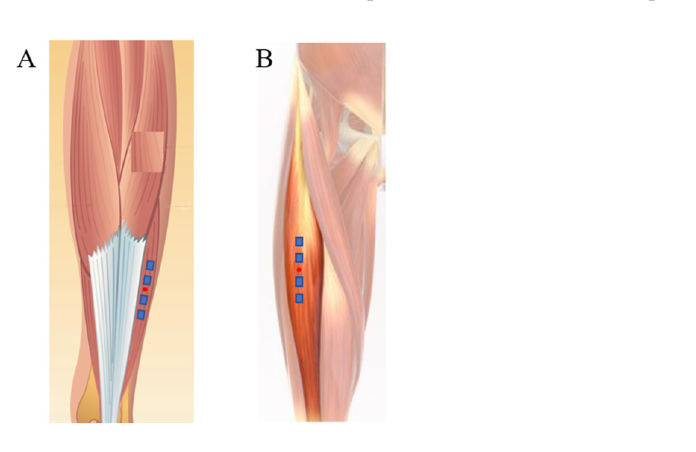
Figure 3. Accelerometer position on muscle bundle: ( A ) soleus [26] and ( B ) rectus femoris